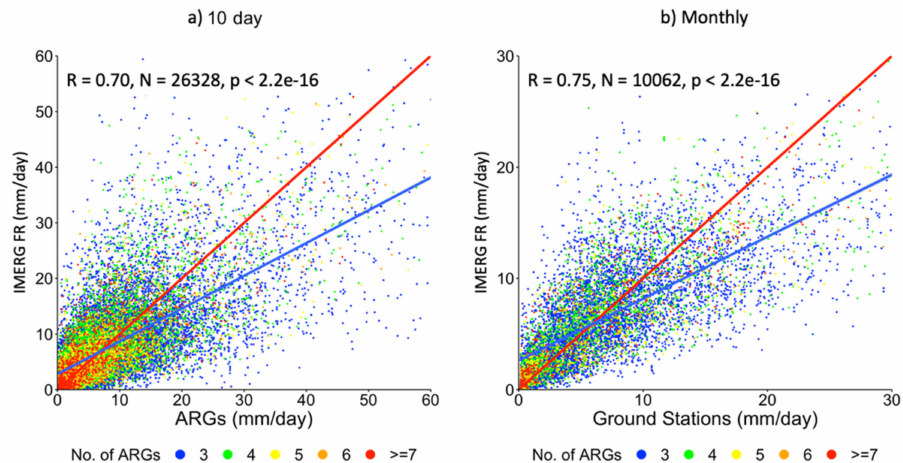
Figure 9. Average of ARG station values within IMERG FR footprint compared with actual ( a ) 10 day and ( b ) monthly rainfall value of the IMERG FR. Red line depicts 1:1 rainfall values. Blue line represents the result of linear regression analysis.